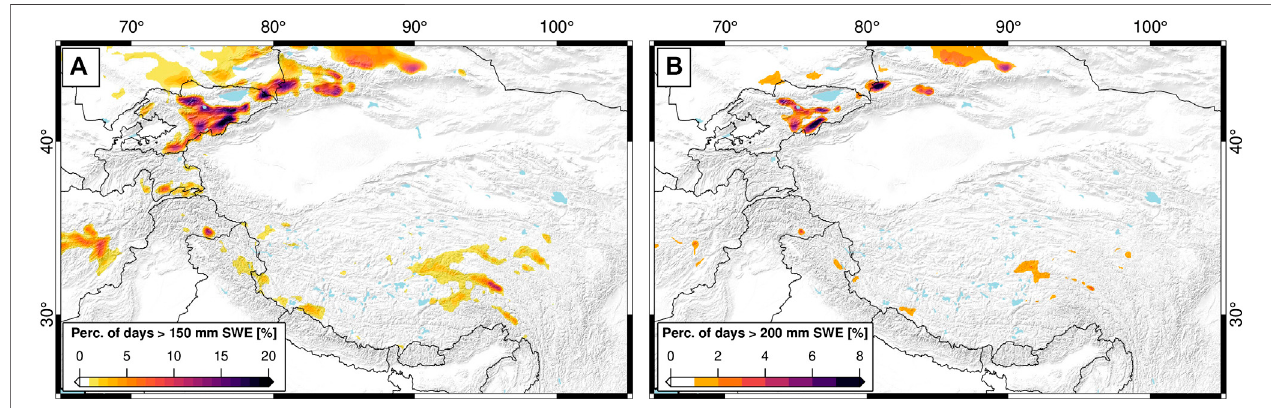
FIGURE 10 | Percentage of days with snow-water equivalent (SWE) above (A) 150 mm and (B) 200 mm (1987 – 2016). While some areas — particularly in the Tien Shan — are impacted by SWE signal saturation, the majority of the study area should not see large signal saturation effects. Many regions where there are saturation effects also do not yield statistically signi fi cant SWE trends, and are thus not considered in our discussion of SWE trends (see Figure 3 ).